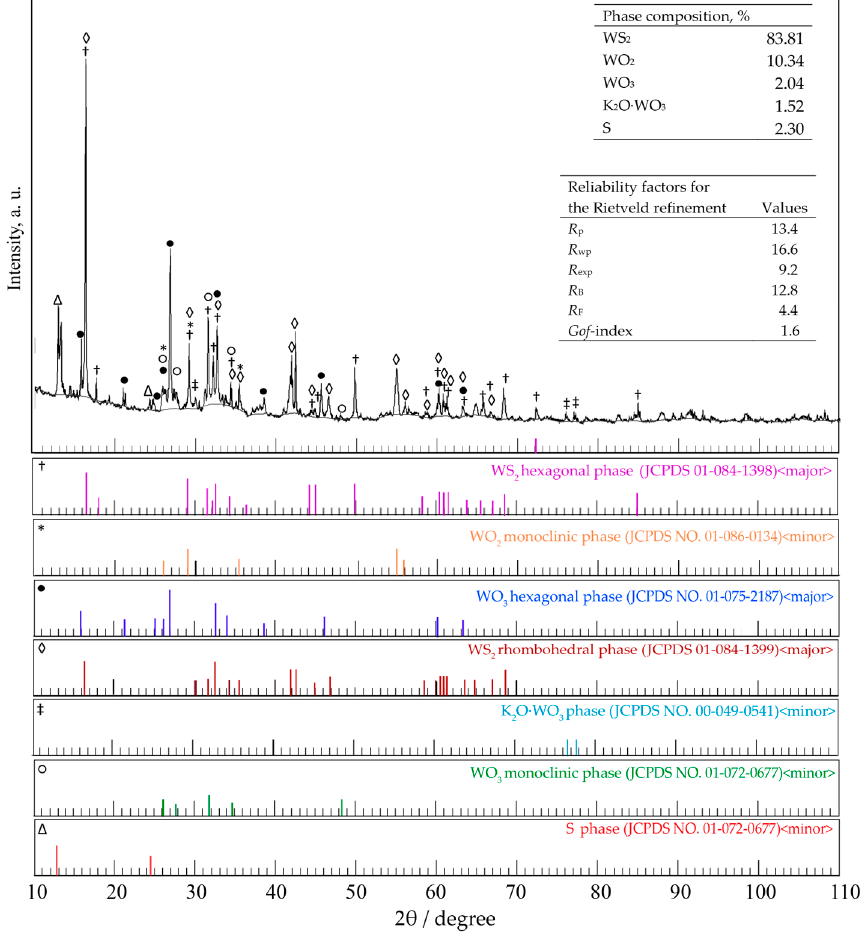
Figure 15. XRD pattern of WS 2 synthesized using commercial WO 3 as precursor.